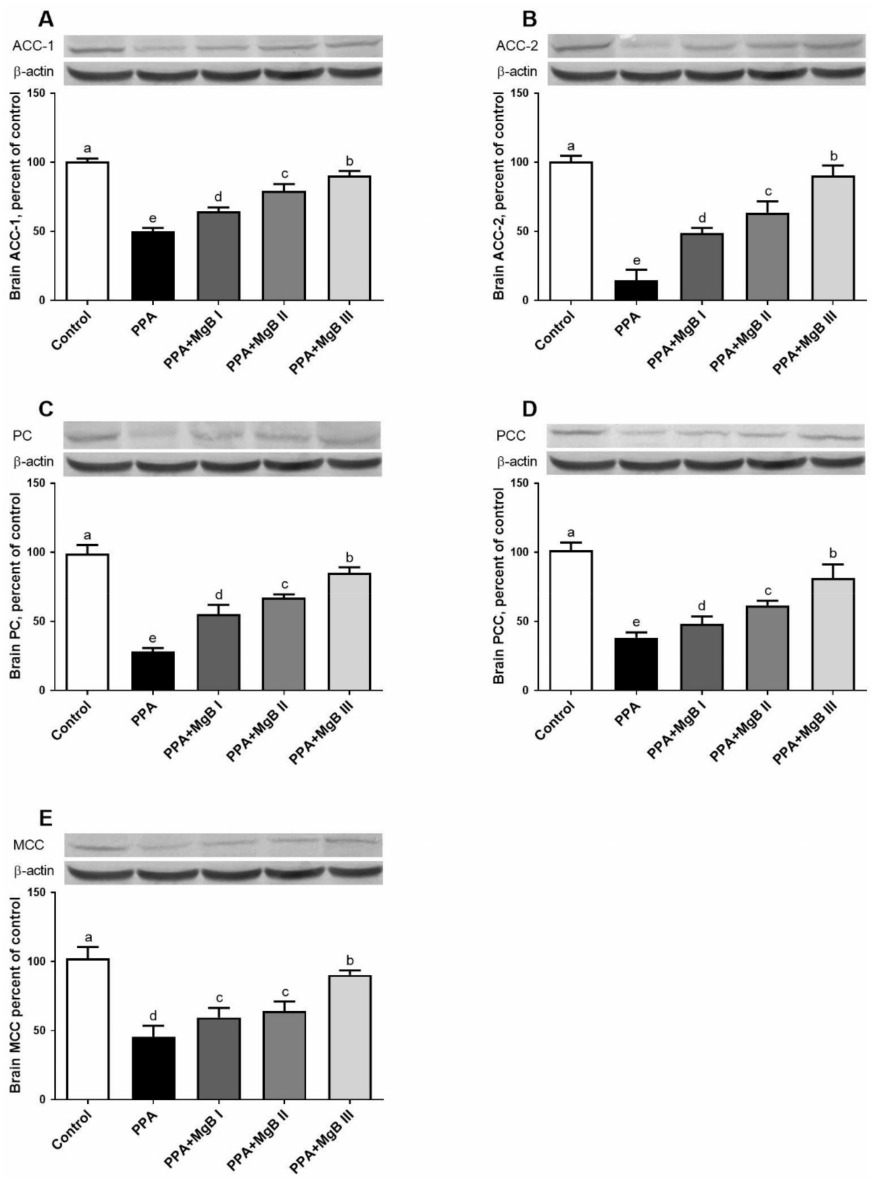
Figure 4. Effects of MgB supplementation on brain acetyl CoA carboxylase 1 (ACC-1, ( A )), acetyl